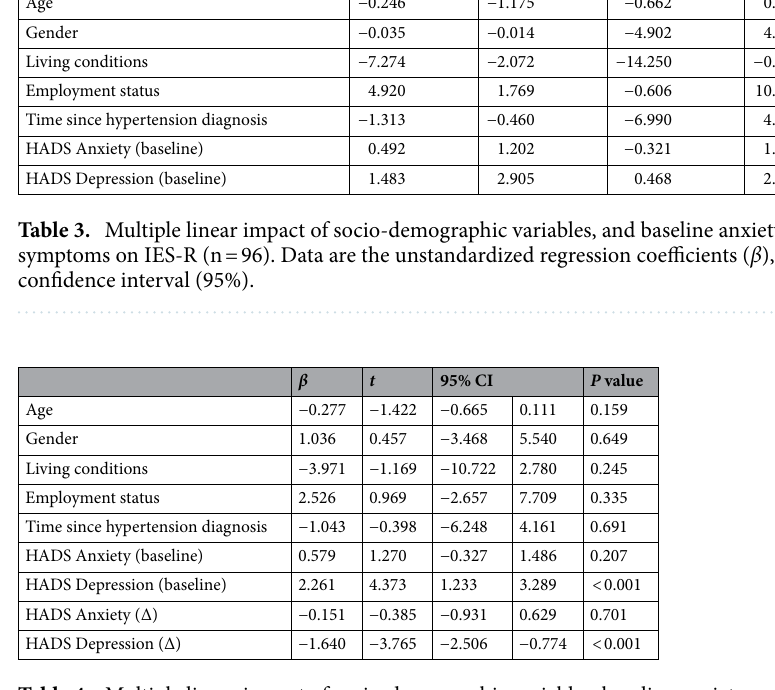
Table 4. Multiple linear impact of socio-demographic variables, baseline anxiety and depression symptoms, and their change after 10 years on IES-R (n = 96). Data are the unstandardized regression coefficients ( β ), the t-test value ( t ), and confidence interval